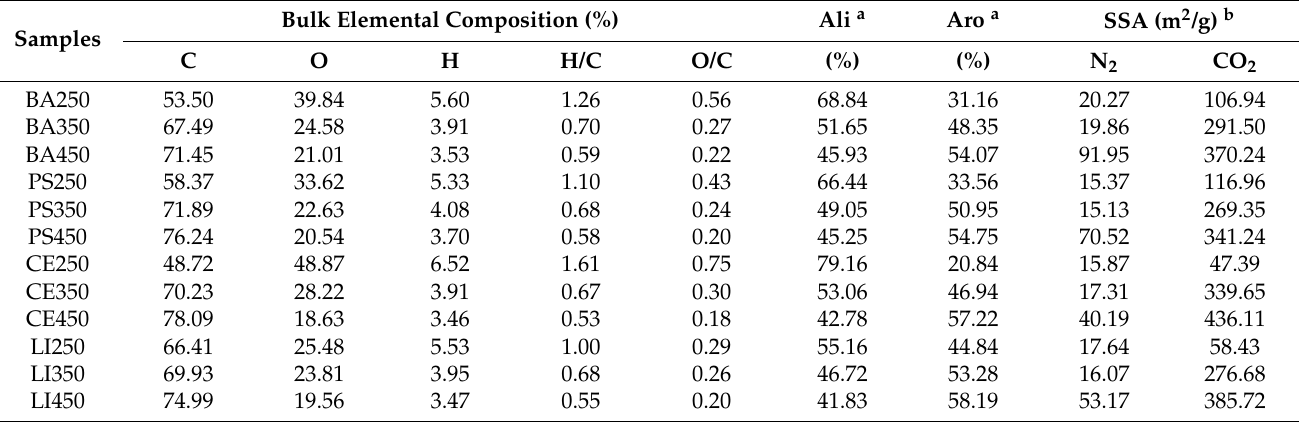
Figure 1. The thermogravimetric analysis with differential scanning calorimetry (TG-DSC) of BA, PS, CE, and LI in the temperature range of 100–600 ◦ C. The exo represent the exothermic direction of DSC curves. Table 1. The elemental composition, carbon phases, and SSA of various